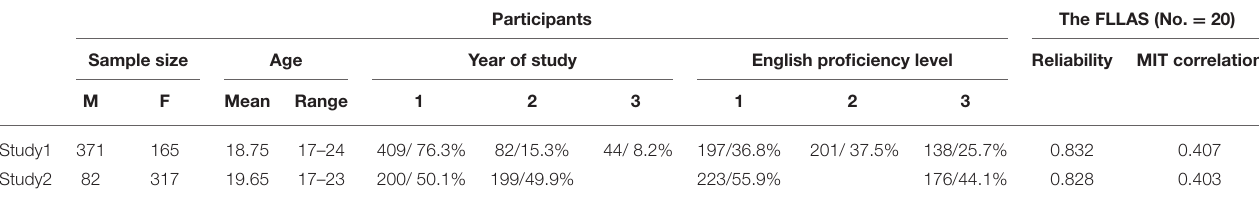
TABLE 2 | Characteristics of the participants and the